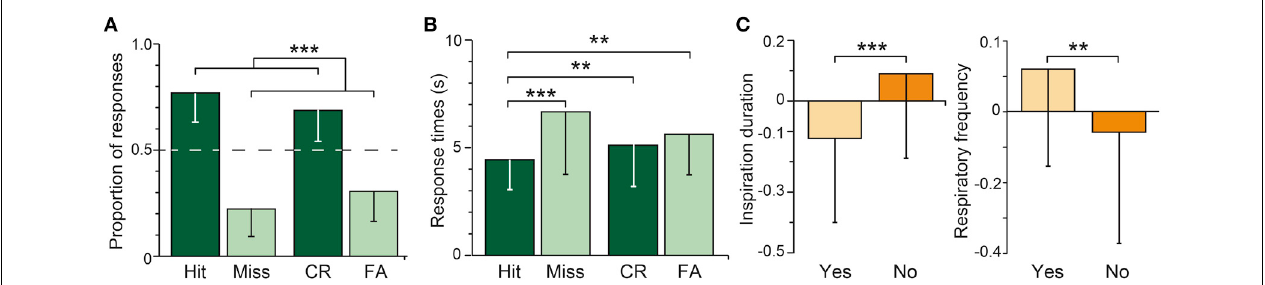
FIGURE 3 | Odor recognition. (A) Mean distribution and (B) mean response times of correct (black) and incorrect (gray) responses for the target (Hit, Miss) and distractor (CR, FA) odors. (C) Mean normalized inspiration duration